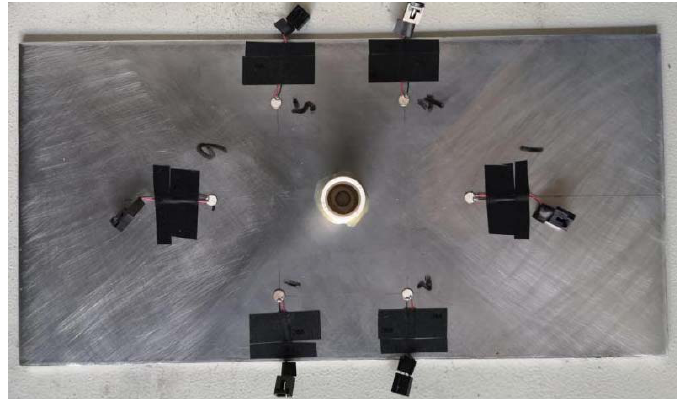
Figure 11. Sample being corroded.